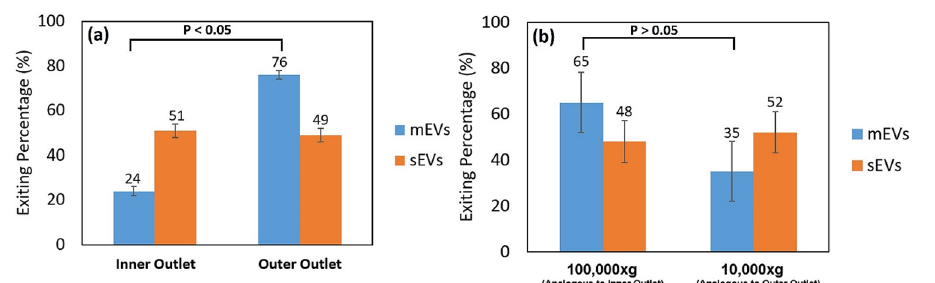
Figure 10. Results of (a) elasto-inertial focusing test on the mixture of U87 sEVs and U87 mEVs (test B4). Exiting percentage of particles from the inner outlet (left) and the outer outlet (right). n = 3, error bars = standard deviation (SD). (b) Re-isolation of U87 mEVs and sEV from a mixture U87 mEVs and U87 sEVs. sEV and mEV retrieval at 110,000× g and 10,000× g is equivalent to "inner" and "outer" retrieval of sEVs and mEVs respectively using the spiral